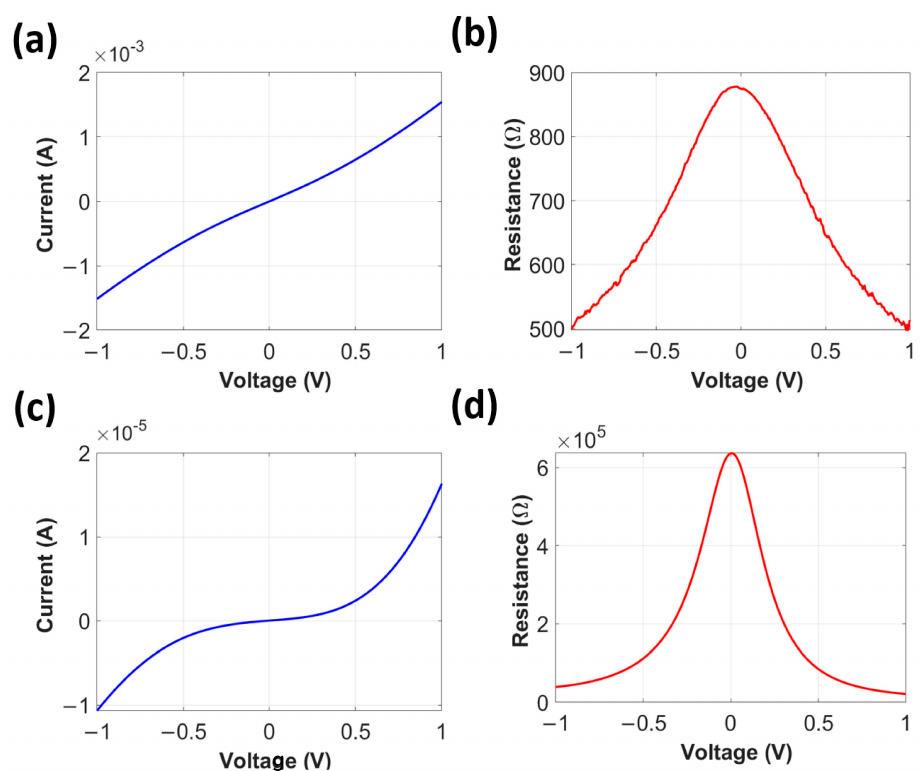
Figure 6. ( a , c ) Diode I-V curve and ( b , d ) differential diode resistance (R d ) measurement from the linear and nonlinear devices,